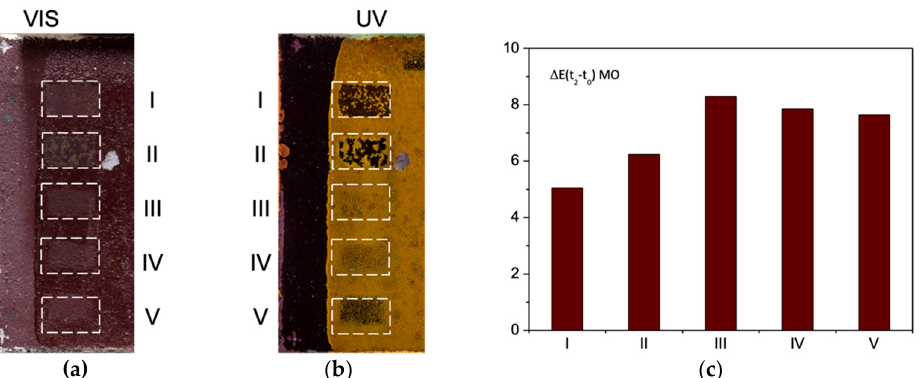
Figure 5. Morellone specimen as a function of laser treatment (I–V): ( a ) visible image; ( b ) UV-induced visible fluorescence; ( c ) bar plot of ∆ E values. Each tested area I–V refers to 1 × 2 cm 2 area. Table 4 documents the colorimetric coordinates at t 0 , t 1 , t 2 . The shellac application (t 1 ) induced a decrease in L*, ∆ L t1 − t0 = − 14.0, and an increase in a* and b* values ( ∆ a t1 − t0 = 7.0